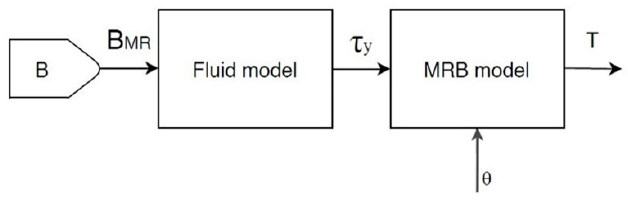
Figure 3. Mechanical model of MR brake.